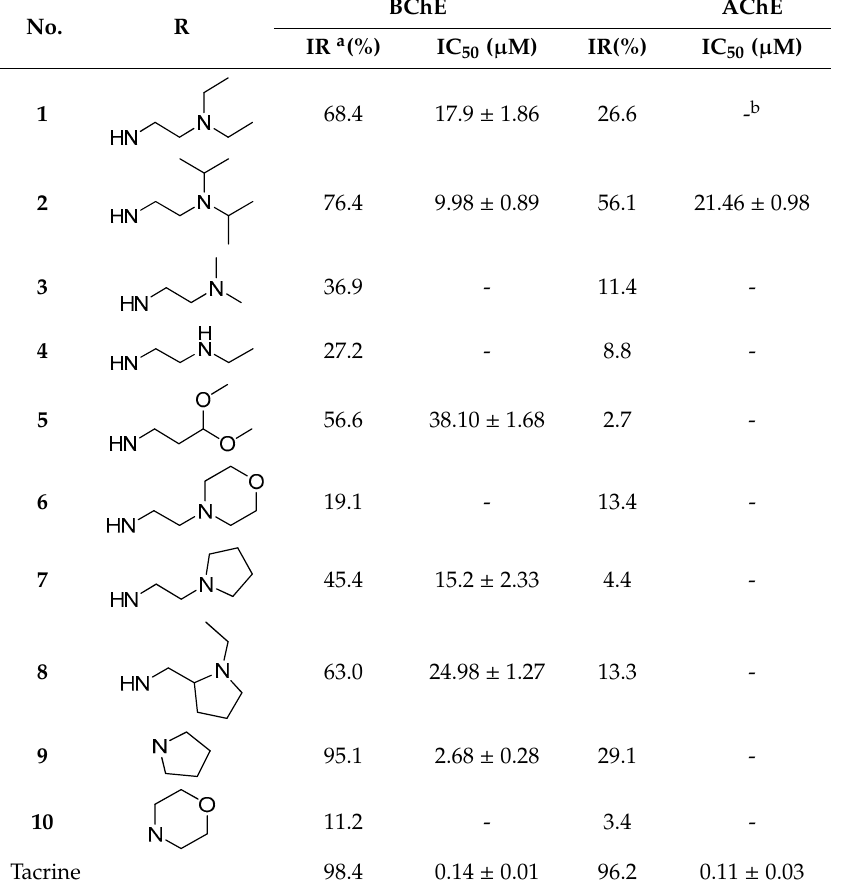
Table 1. The inhibitory activities of compounds 1–10 against ChEs.